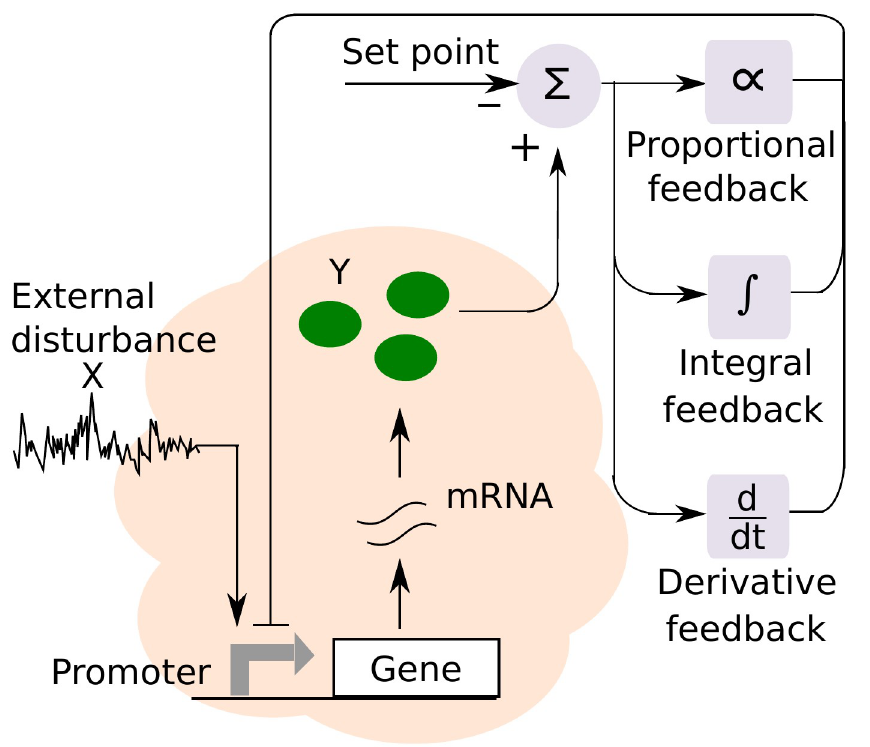
Fig 1. Schematic of the gene expression process, where a gene is transcribed to produce mRNAs. Each mRNA is subsequently translated to synthesize protein Y molecules. The expression process is impacted by an upstream external disturbance. Proportional-integral-derivative (PID) controllers can be designed to minimize fluctuations in Y copy number around a desired set point.